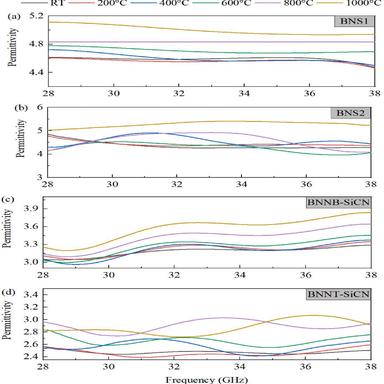
High-temperature free space permittivity from room temperature to 1000 ◦C over the frequency range from 28 to 38 GHz for a) BNS1, b) BNS2, c) BNNB-SiCN, and d) BNNT-SiCN PDC samples.